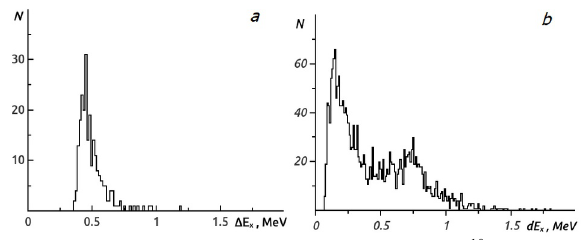
Fig. 5. Simulations of ionisation loss spectra with 10 B detector in the first gas gap for: (a) thermal energy; (b) 3 MeV energy .